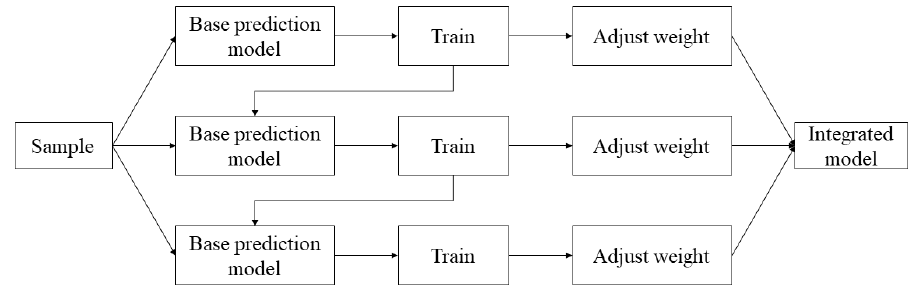
Figure 8. The schematic diagram of GBDT.